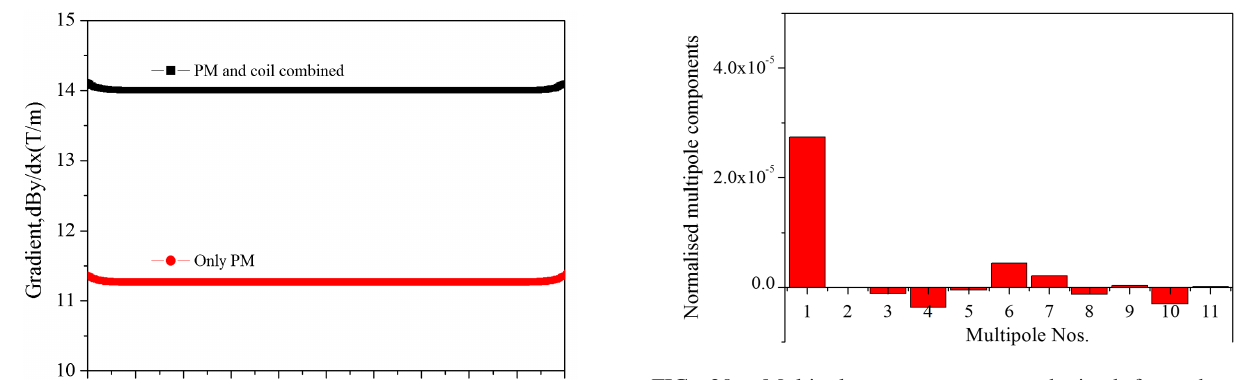
FIG. 20. Multipole components, as obtained from the 2D calculation, normalized with the quadrupole component are shown for the assembly of 24 PMs.